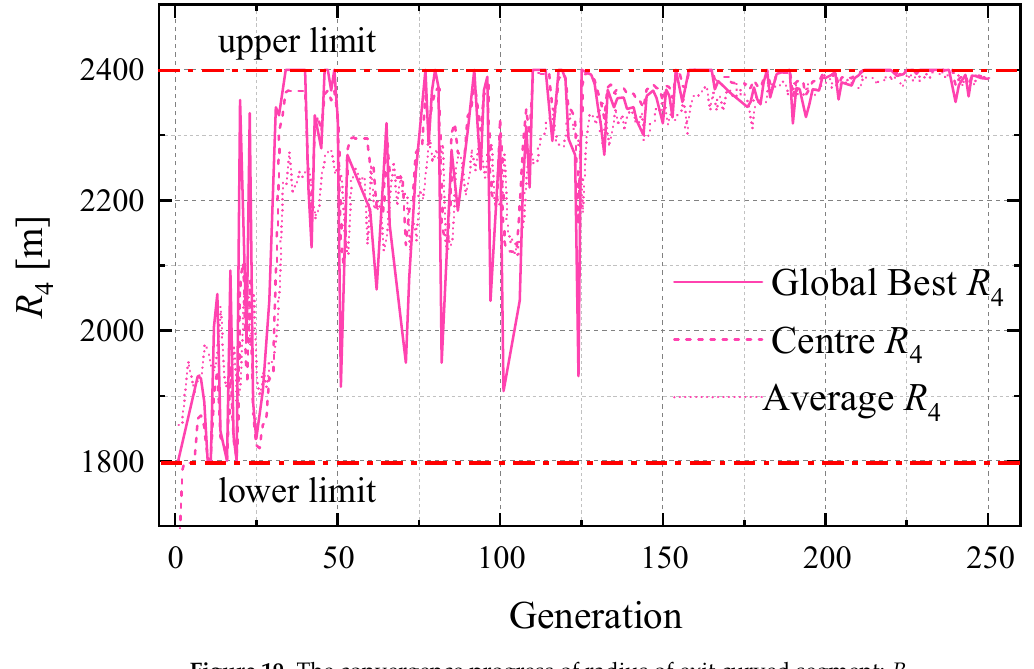
Figure 18. The convergence progress of radius of entry curved segment: R 2.